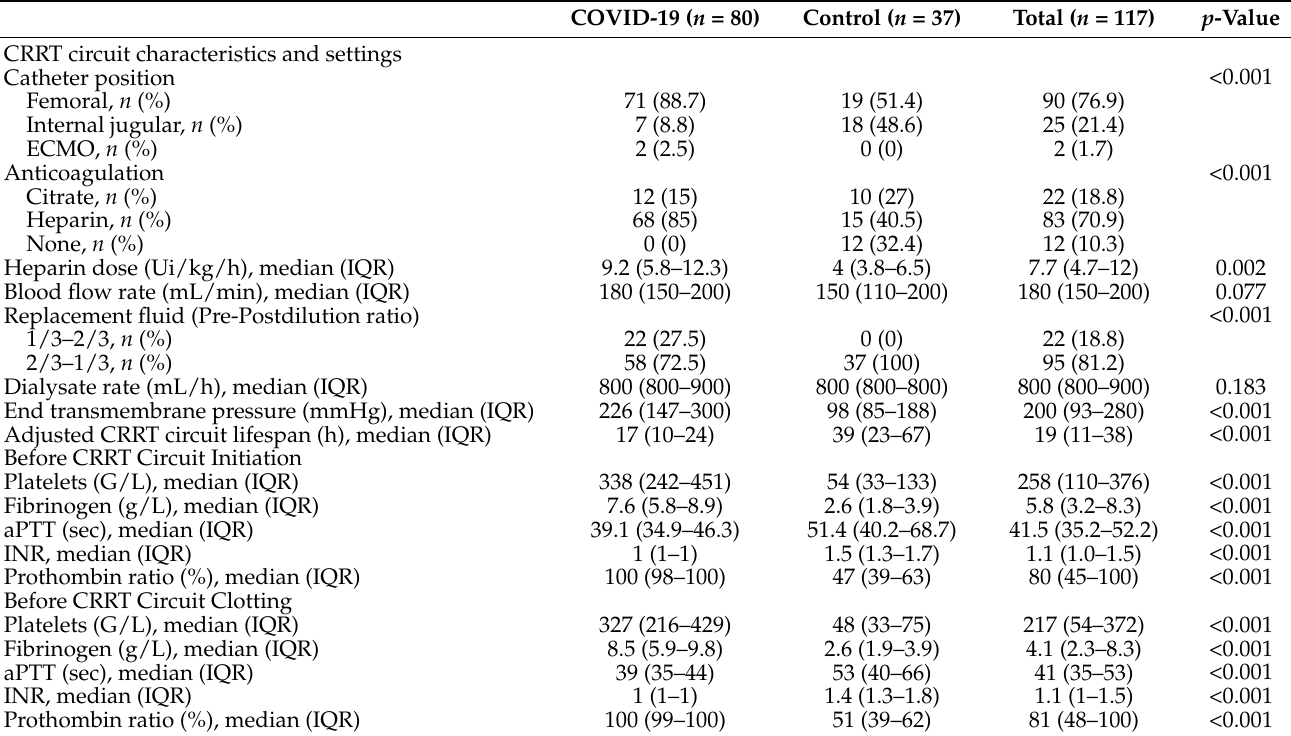
Table 2. Profile of CRRT Circuits.